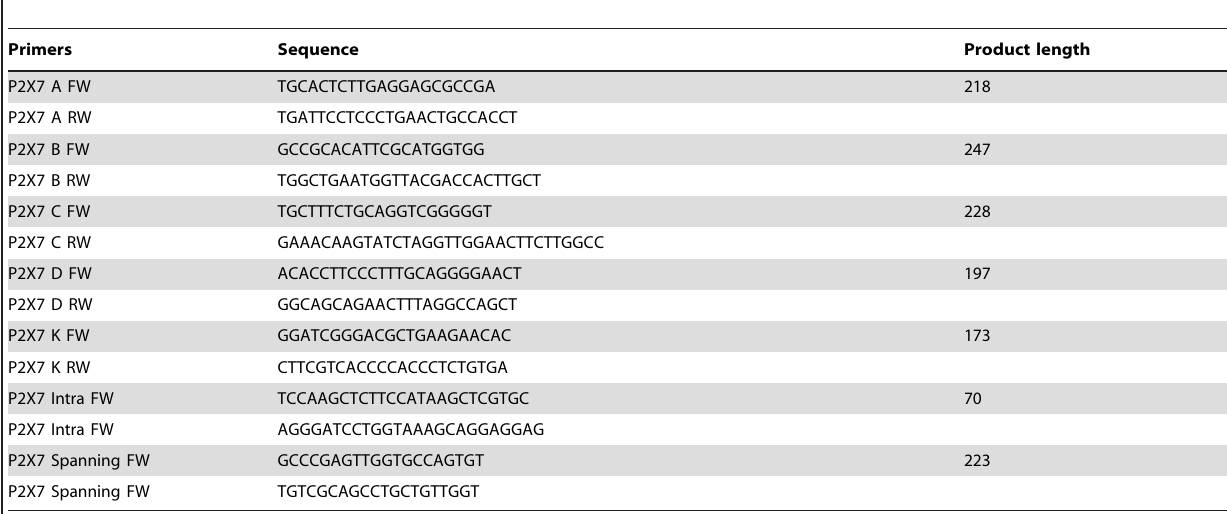
Table 1. Primer sets used for RT-PCR on PSCs for isoforms A–D and K, and within the deleted area (Intra) and spanning the deleted area